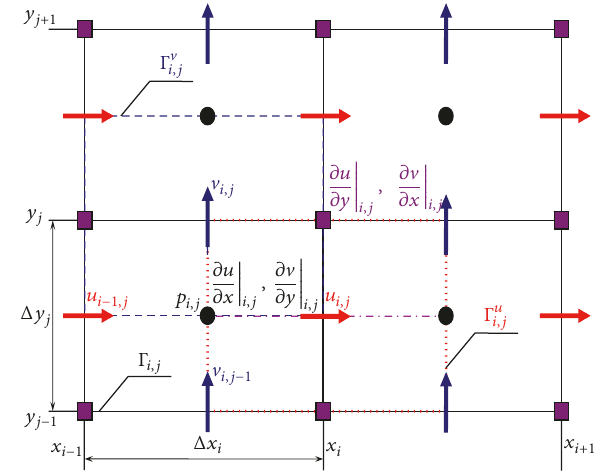
Figure 2: Staggered arrangement of the variables on the modified LS-STAG mesh.